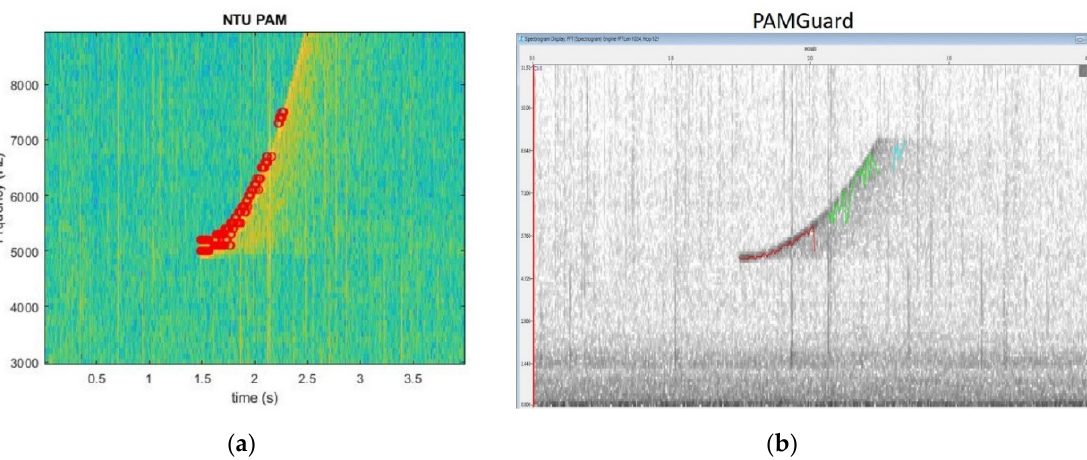
Figure 11. Output results of rising frequency signals: ( a ) NTU_PAM; ( b ) PAMGuard with 1024 data points window length, 90% overlap ratio and 6 dB SNR.